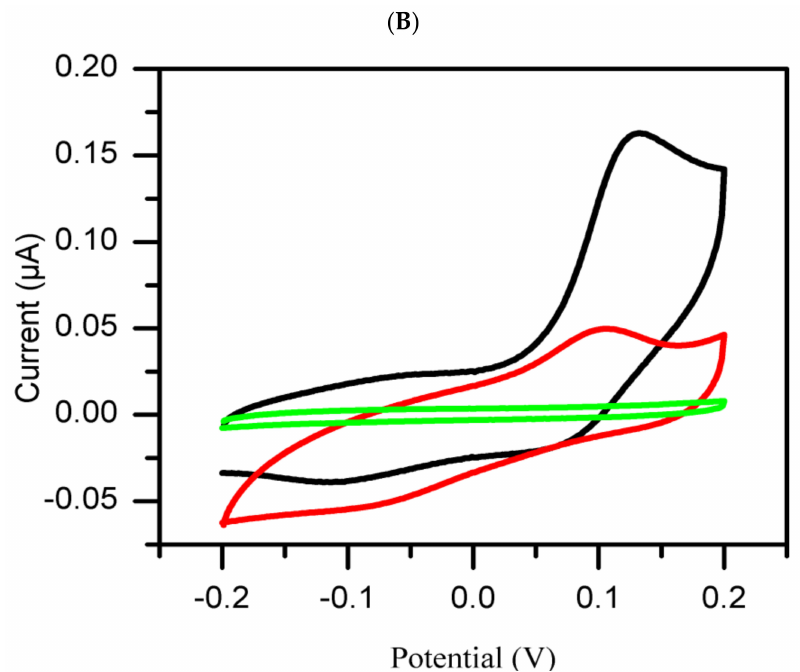
Figure 3. Comparative analysis of representative CVs of each group: Inactive extract ( A , red curve) and active extract ( B , red curve) with negative control (black curve) and positive control (green